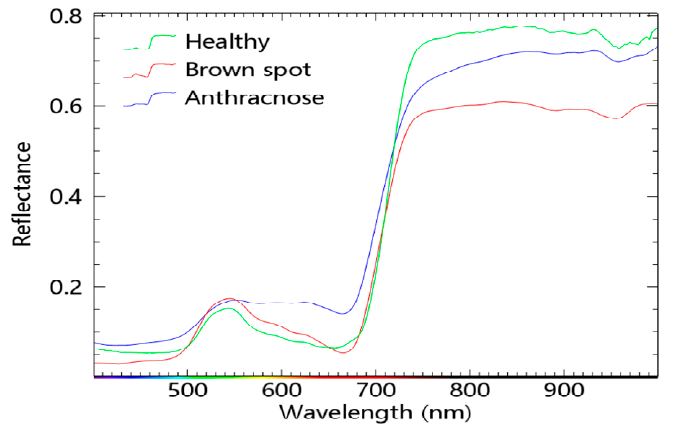
Figure 5. Mean spectral profiles of healthy corn leaves and corn leaves with anthracnose and brown spot .